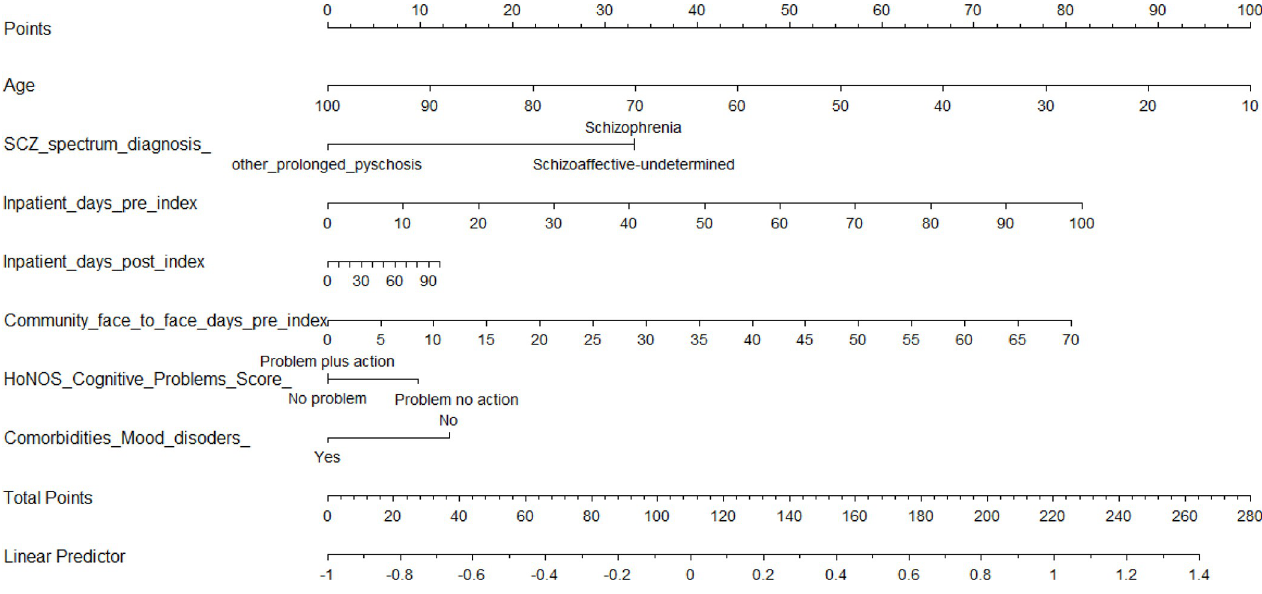
Fig 3. Nomogram for Cox Lasso regression to calculate individual normalized prognostic indexes (PI, given by the linear predictor line) for treatment resistant schizophrenia. Coefficients are based on the Lasso Cox model.—To predict the rate of survival using the nomogram, one can take the example of a 30-year-old patient, with Schizophrenia, having 34 inpatient days recorded at 3 months before the 1st antipsychotic (AP) date, 50 inpatient days recorded 3 months after 1st AP date, 15 community face-to-face days recorded 3 months before 1st AP date, having a minor problem requiring no action and having mood disorders as comorbidity, has a total point score of 78 + 33 + 28 + 6 + 18 + 10 + 0 = 173. This corresponds to a normalized prognostic index of 0.57 (linear predictor line) for TRS, meaning that the patient has a probability to become TRS at 1 year falling in the range 4.14%-7.66%, at 2 years falling in the range 7.62%-13.89%, at 5 years in the range 16.45%-28.74% and at 10 years in the range 26.57%-44.13% (see S3 Table).